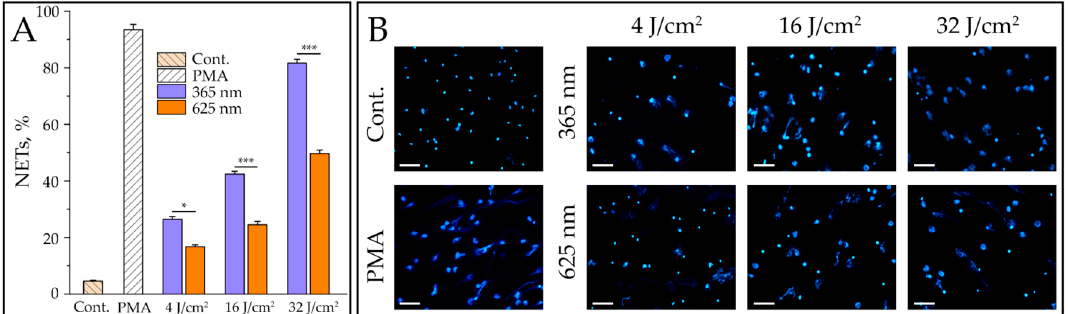
Figure 4. The release of NETs depending on dose at wavelengths of 365 and 625 nm. Freshly isolated neutrophils of healthy donors were irradiated with LED-lengths of 365 and 625 nm (UV-A and orange light spectrum, respectively) and doses 4, 16, and 32 J/cm 2 . NET formation was registered after 3 h incubation at 37 ◦ C and 5% CO 2 using fluorescence microscopy. The data represent the mean ± SD from five independent experiments ( n = 5). Statistically significant p values are indicated as follows: * p < 0.05, and *** p < 0.001 ( A ). The corresponding representative images of neutrophils irradiated with LED-length of 365 and 625 nm or stimulated with PMA are shown. Bars: 50 µ m ( B ).